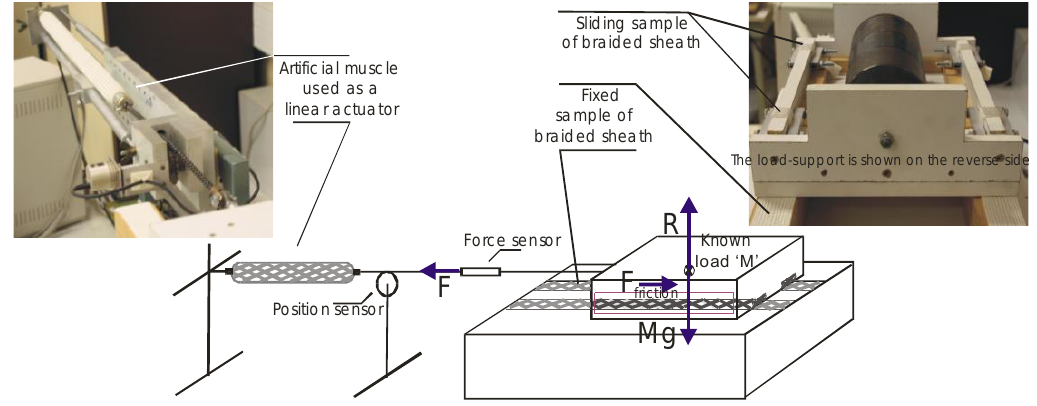
Figure 4. Experimental estimation of the kinetic friction coefficient of our flattened rayon sheath sliding over itself ( a ) and comparison with a typical curve showing the kinetic friction coefficient variation for a rayon staple fiber sliding over a cylindrical array of similar fibers (redrawn from [19] with data from